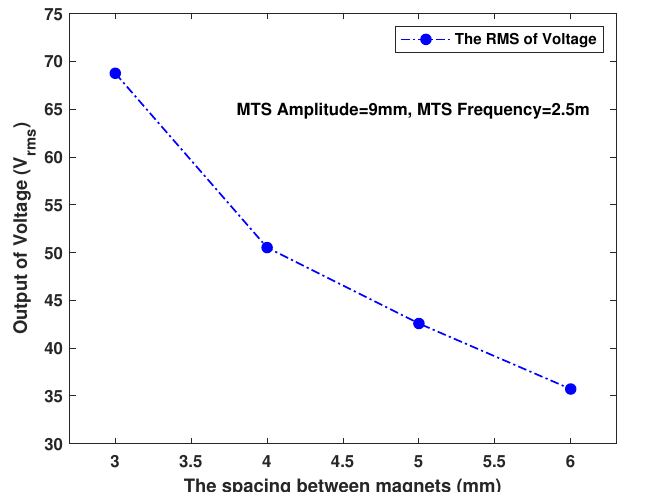
Figure 10. Output voltage reliance on the spacing between the two permanent magnets of the stator and the